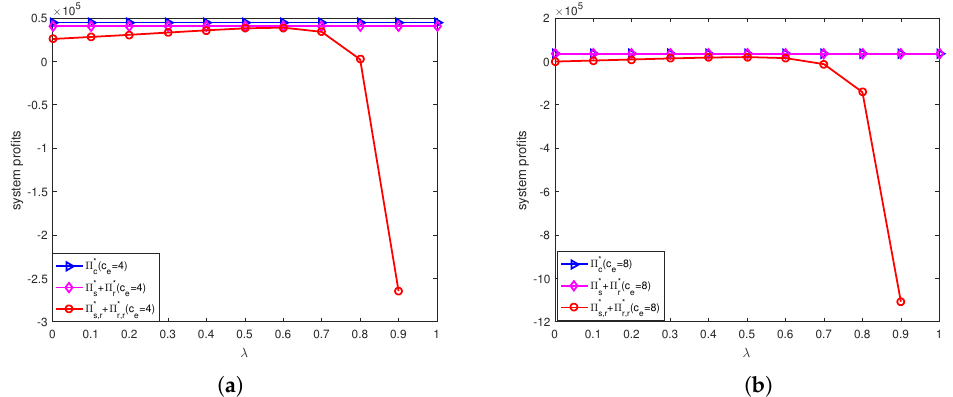
Figure 9. Profit comparison before and after offline channel price discount contracts under different unit price of carbon trade: ( a ) c e = 4. ( b ) c e =